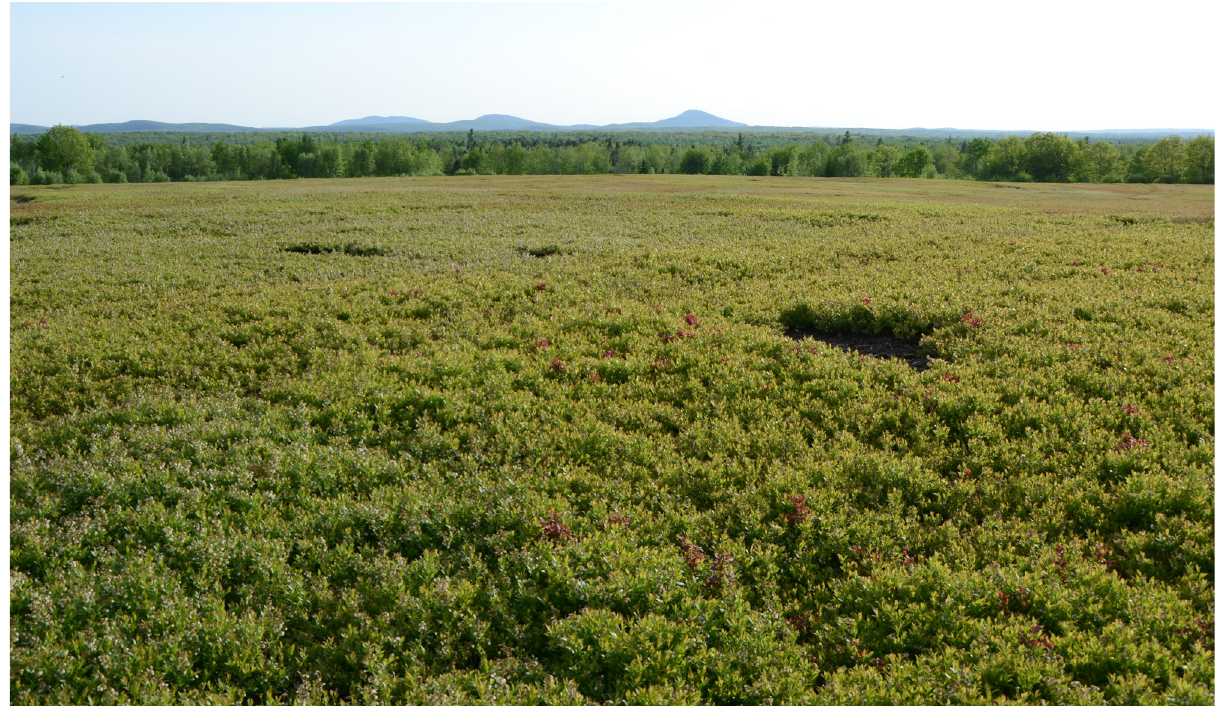
Figure 1: Photo of wild blueberry field in Maine, USA. This Illustrates a wild blueberry field and the surrounding landscape typical of the region. The field is surrounded by a hard edge of forest and except for the crop itself, very few flowering plants are present in the landscape to support wild pollinators throughout the